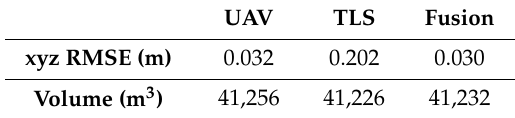
Table4. PointcloudaccuracyandvolumecomputationresultsofUAV,TLS,andTLS / UAVfusionmodels. UAV TLS